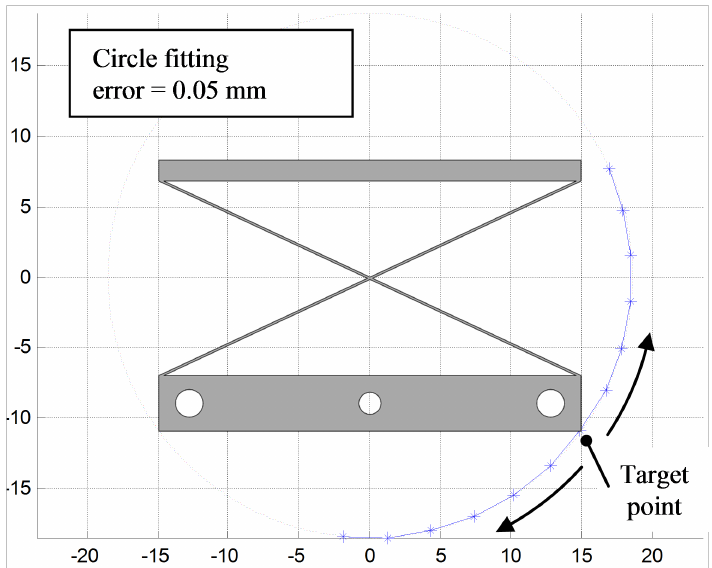
Figure 14. Observed trajectory of a target point on the tested X 2 pivot and circle fitted to the collected data